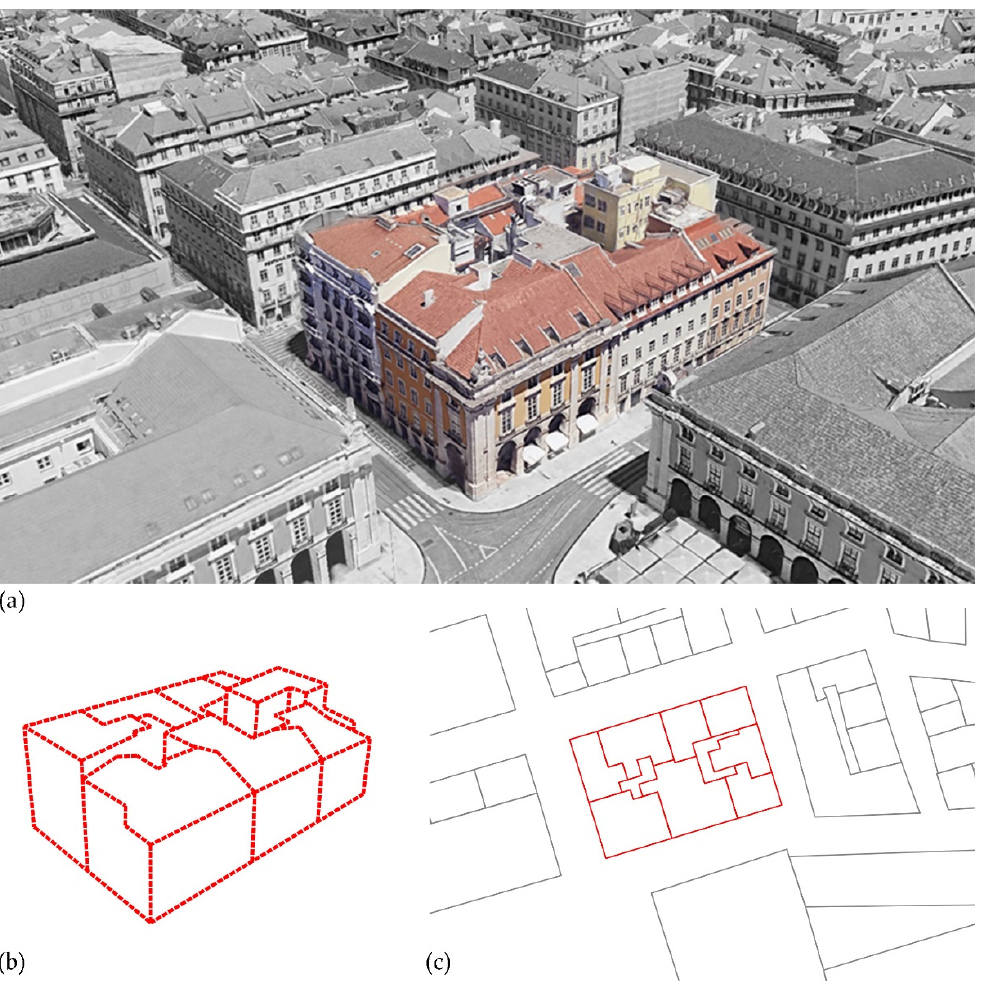
Figure 9. A block of the city ( a ) can present one or more MUs ( b ). They usually match with the division of the block in the cartography ( c ).